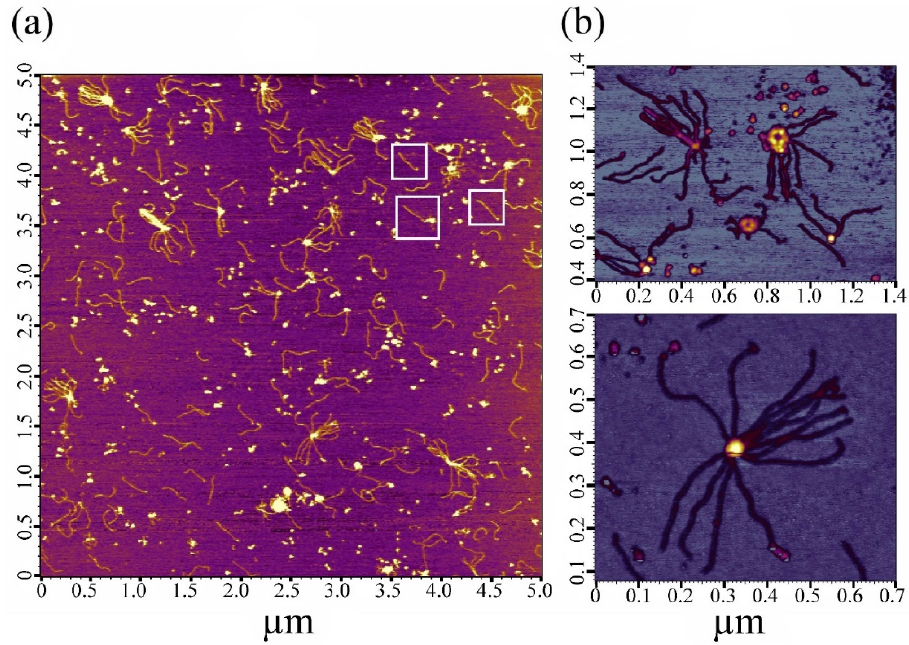
Figure 2. AFM images of molecular SMT HMW obtained in a solution of 0.6 M KCl, 30 mM KH 2 PO 4 , 1 mM DTT, 0.1 M NaN 3 , and pH 7.0. In the field of view, there are filamentous protein molecules— monomers (marked with white squares) ( a ), which assemble into oligomers forming a central thick- ening ( b ).